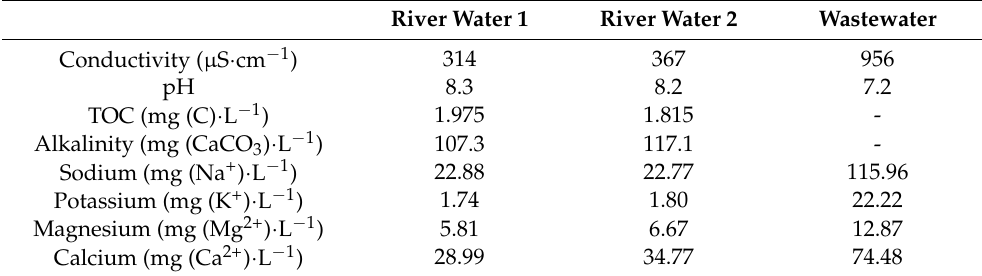
Table 1. Main chemical characteristics of river waters and wastewater used in this